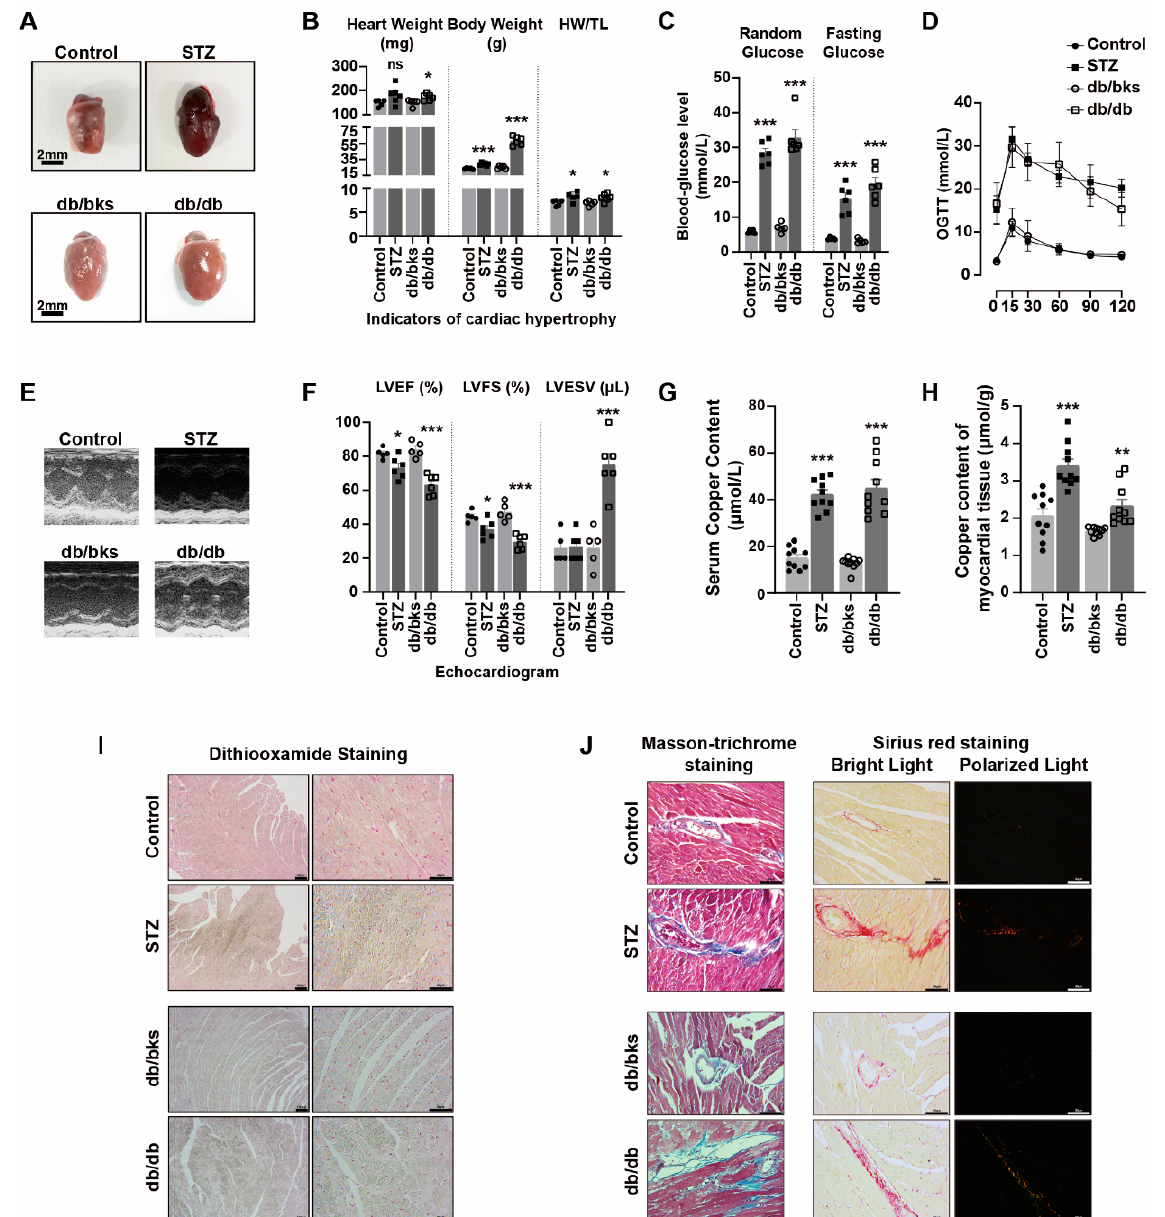
Figure 5. Elevated copper level of peripheral blood circulation and myocardial tissue aggravated myocardial damage in diabetic mice. ( A ) Representative gross morphologic pictures of murine heart. ( B ) Heart weight, body weight and HW/TL ratio of diabetic mice ( n = 5–6). ( C ) Random and fasting glucose level of diabetic mice ( n = 5–6). ( D ) Oral glucose tolerance test (OGTT) of diabetic mice ( n = 5–6). ( E ) Representative M-mode echocardiographic changes in diabetic mice. ( F ) Left ventricular ejection fraction (LVEF), fractional shortening (LVFS) and left ventricular end-systolic volume (LVESV) of diabetic mice ( n = 5–6). ( G ) Serum copper content of diabetic mice ( n = 10). ( H ) Copper content of myocardial tissue in diabetic mice ( n = 10). ( I ) Copper salt stained with dithiooxamide method in diabetic myocardial tissue by IHC. ( J ) Cardiac fibrosis with Masson-trichrome staining and Sirius red staining of diabetic mice. * p < 0.05, ** p < 0.01, *** p <